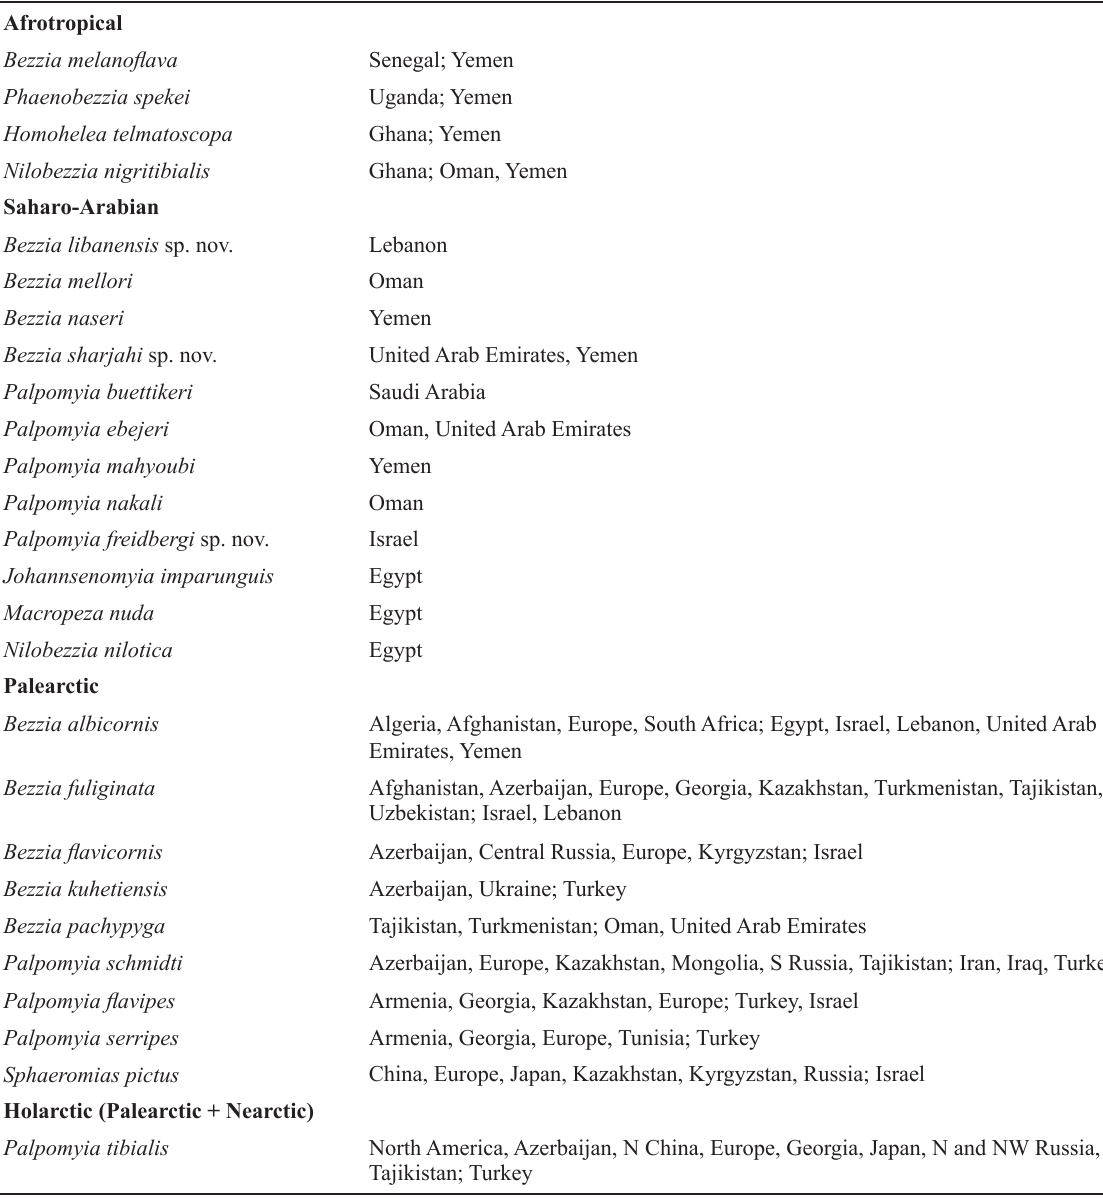
Table 1. Zoogeographical elements among the Middle East Palpomyiini and Sphaeromiini.